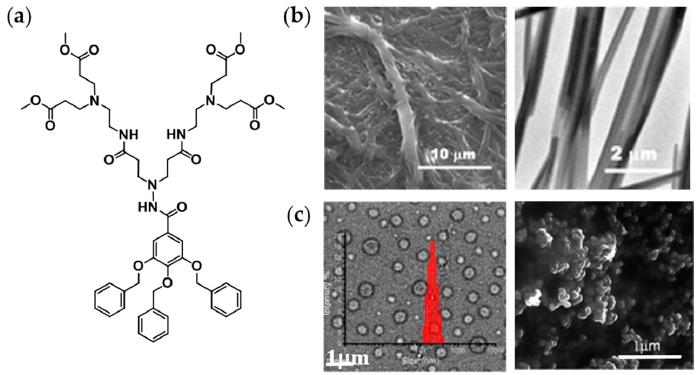
Figure 9. ( a ) JD from poly(aryl ether) linked PAMAM; ( b ) SEM ( left ) and TEM ( right ) images of xerogel of the amphiphile in DMSO/water mixture; and ( c ) TEM images superimposed with DLS data ( left ) and SEM images ( right ) of vesicles in EtOH/water mixture. Copyright Wiley-VCH, reprinted from ChemistrySelect 2016